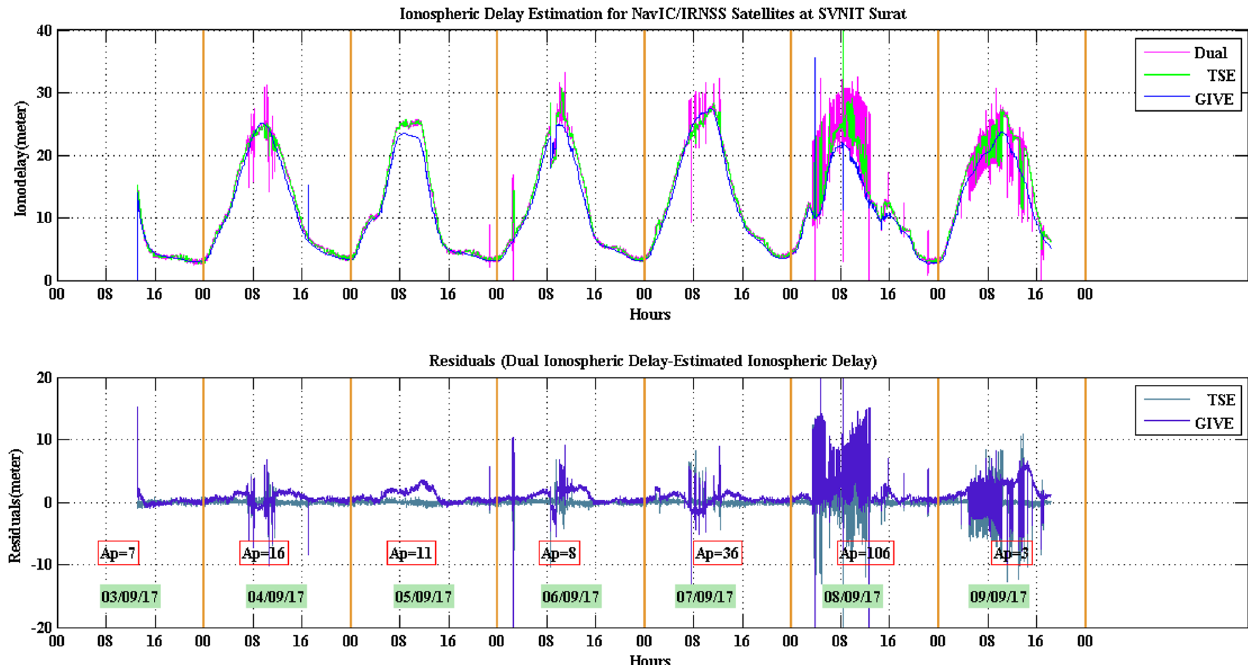
Fig. 8. The average ionodelay performance comparisons of TSE, dual frequency and GIVE model for NavIC/IRNSS satellites at the SVNIT Surat on the observation duration (3 – 9 September 2017).